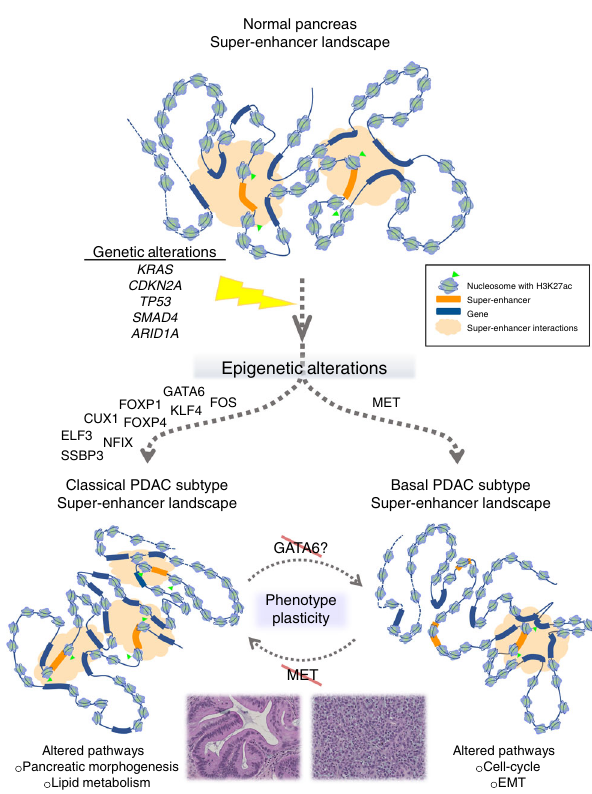
Fig. 2 Epigenomic landscapes explain the progression of PDAC into two subtypes. While PDAC initiates with certain genetic alterations, including KRAS , CDKN2A , TP53 , and others as indicated, mounting evidence reveals that the subsequent establishment of the classical and basal subtypes is a consequence of epigenetic alterations, which include speci fi c super- enhancers driven by distinct upstream regulators to result in altered gene expression networks that de fi ne each subtype 33 . Experimental data from knockdown of MET in the basal subtype substantiates the potential conversion to the classical subtype, suggesting the possibility of phenotype plasticity 33 . Similarly, it may be feasible to convert the classical into the basal subtype through targeting upstream transcription factors,